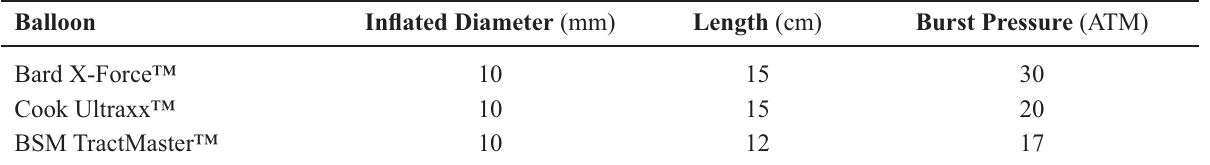
Table 1 – Percutaneous nephrostomy balloons